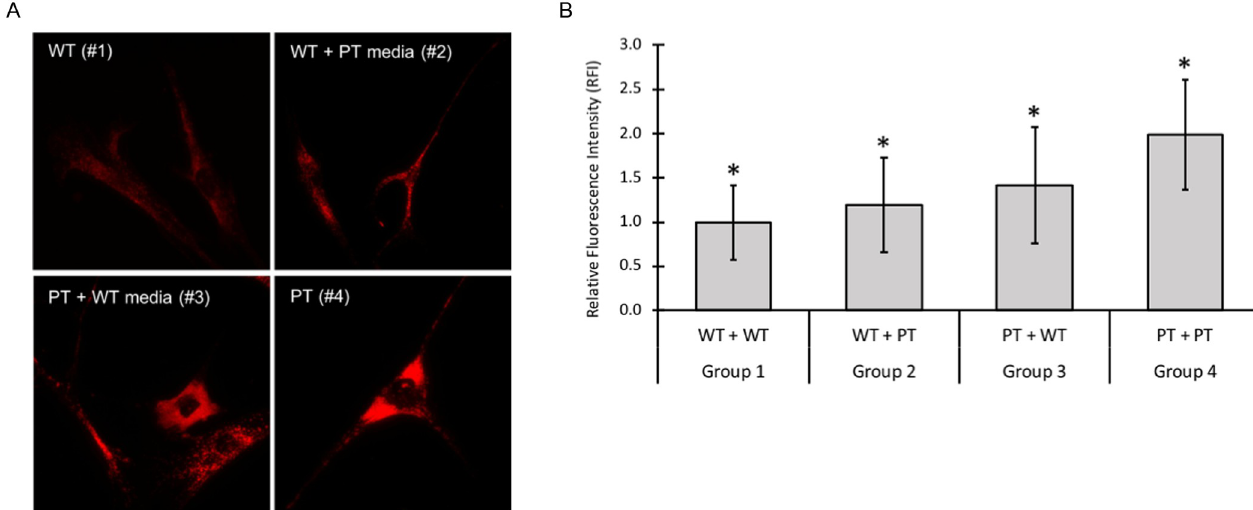
Fig 6. A. LAMP1 fluorescence signal in four conditioned media groups. Cells probed for LAMP1 were imaged using the Texas Red (ex 596nm / em 620nm) filter for fluorescence microscopy. B. Quantitative analysis of LAMP1 signal intensity in conditioned media groups. Relative fluorescence intensity (RFI) was measured using ImageJ (n = 3 replicates per group). Significant differences (denoted by � , p < 0.001) were found between all conditioned groups. Error bars indicate +/- SD.